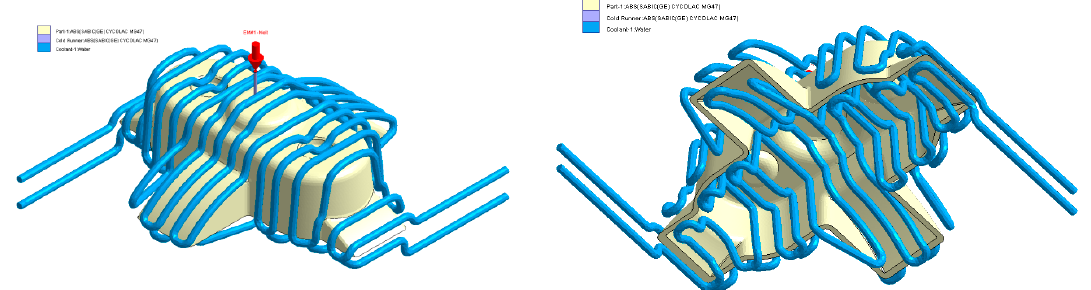
Figure 15. Cooling system design, Case A. Front view ( left ) and bottom view ( right ).